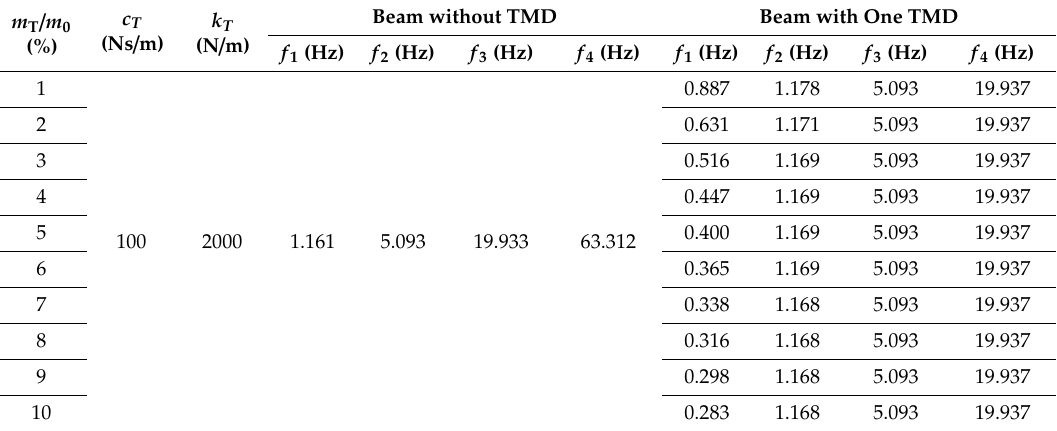
Table 1. Variation of the first natural frequencies as a function of the m T2 / m 0 ratio.